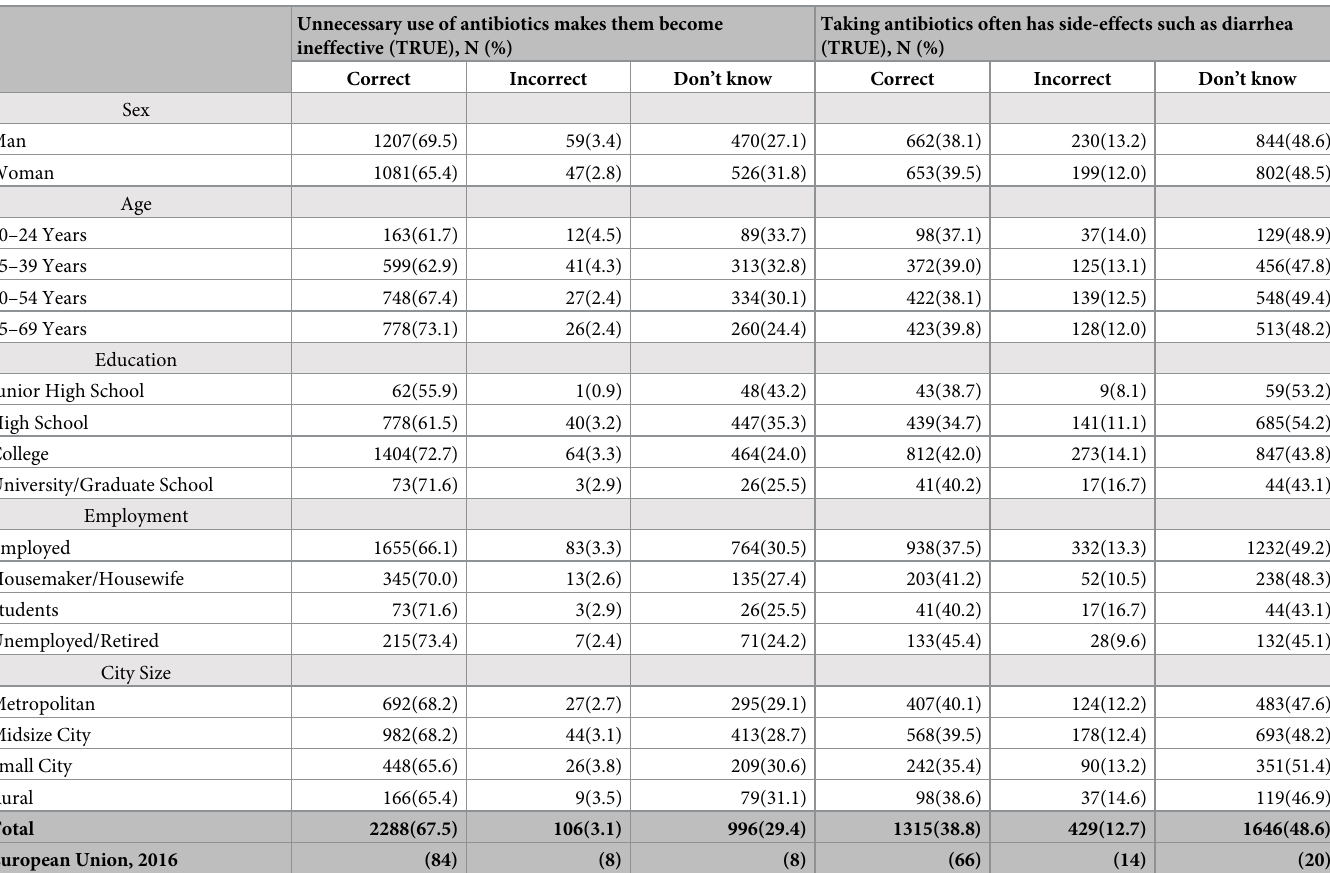
Table 4. Knowledge about adverse effects of